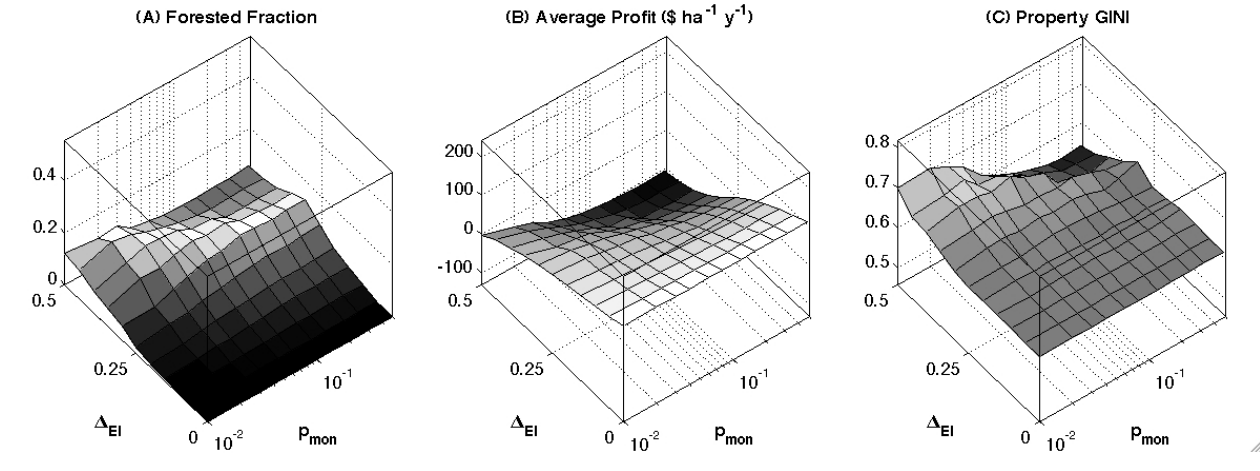
Fig. 6. Response surfaces for Policy Scenario 3 (nontiered environmental licensing), Rancher Scenario 1 (low networking, low size effect) showing sensitivity to change in expected income D EI and in probability of monitoring p . (A) Average forested fraction across the landscape; (B) Average profit mon per hectare of property per year; (C) Level of land aggregation measured by the property GINI coefficient. Response surfaces for Rancher Scenarios 1-4 are shown in Appendix 5, as are surfaces for the standard deviations across